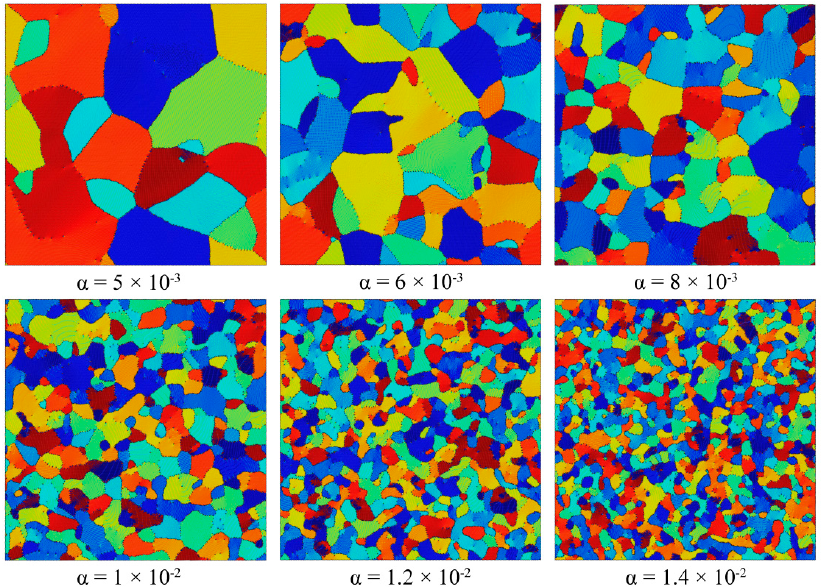
Figure 9. The solidification structure formed by applying different noise amplitudes in the under- cooled homogeneous liquid phase. The other parameters of the simulations are ε = − 0.3, φ 0 = − 0.32, Δ × Δ . Blocks of different colors correspond to grains with different orientations.